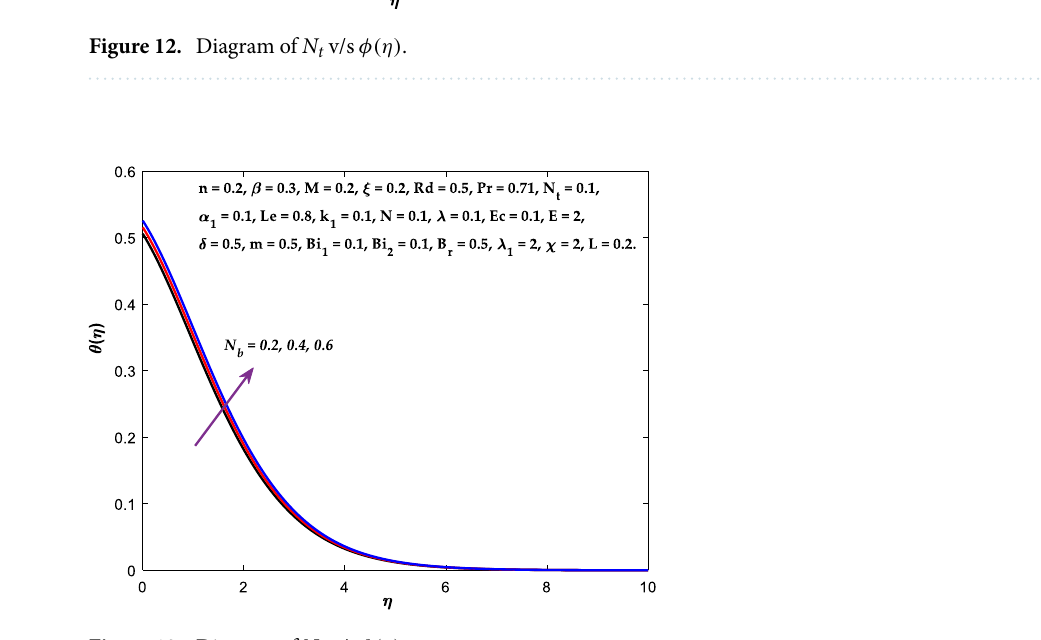
Figure 13. Diagram of N b v/s θ(η)